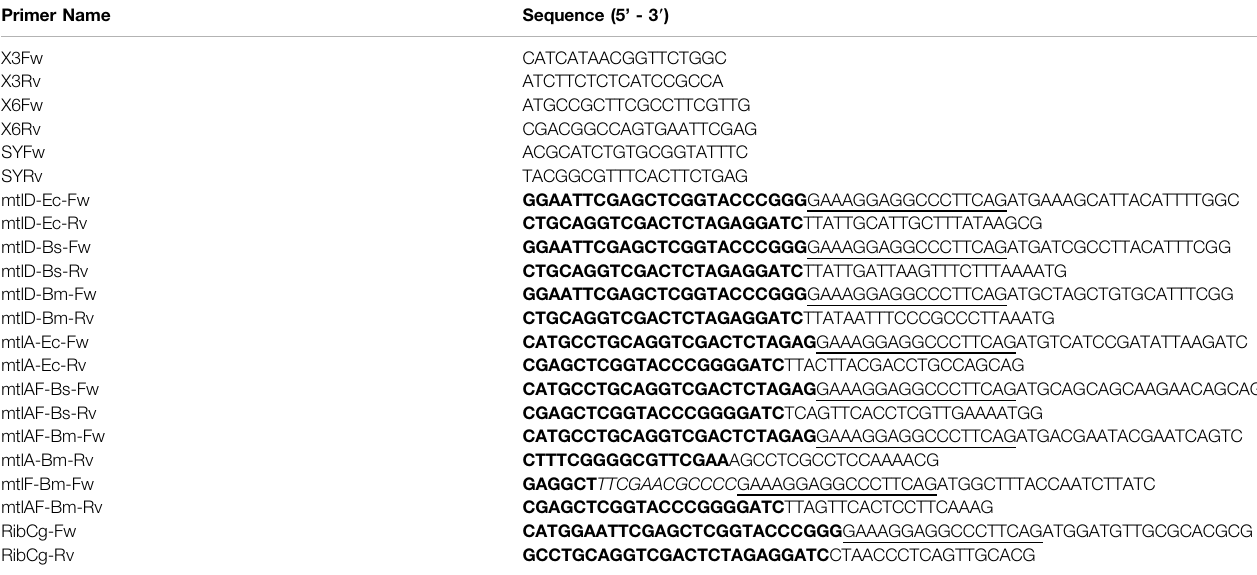
Bold letters: overlapping region. Underlined letters: ribosomal biding site plus spacer. Italic letters: link